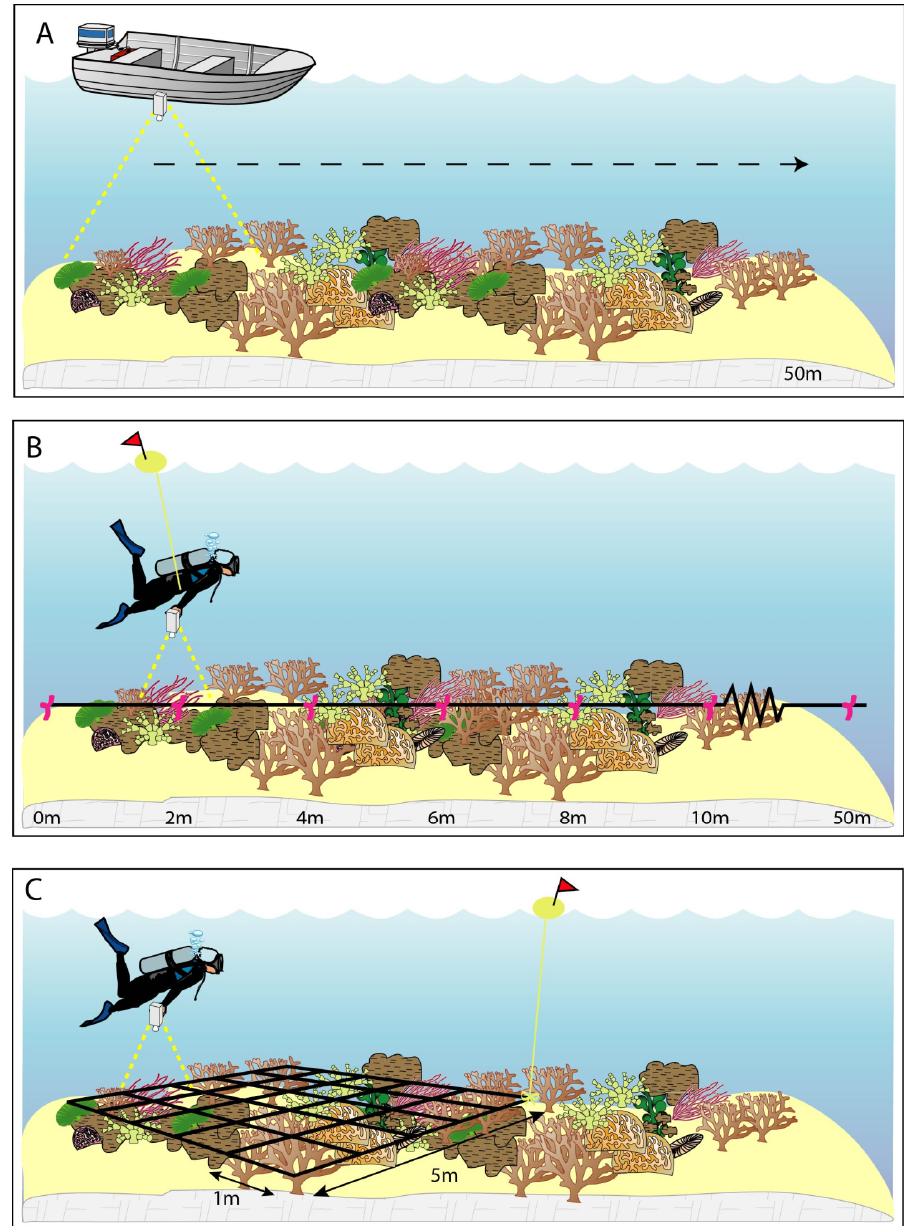
Figure 2. Field survey methods ( A ) 50 m point sampling taking two photos from a submerged camera at the side of the boat (as in April 2001); ( B ) 50 m transect with digital photos taken at 2 m intervals (as in November 2002); and ( C ) 5 × 5 m grid with digital photos taken every 1 m grid cell (as in May/June